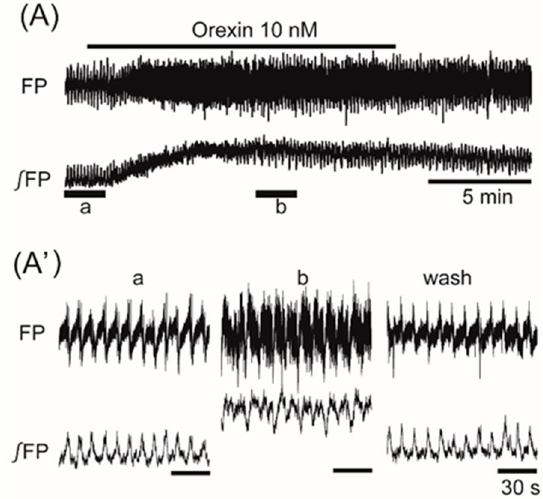
Figure 5. The effects of orexigenic neuropeptide orexin on oscillation in the ventromedial hypothalamus. ( A ) An example of continuous recording of the ventromedial hypothalamus field potential before and after the application of 10 nM orexin. ( A’ ) Faster sweep representation: a and b correspond to records at “a” and “b” in ( A ), and after 20-min washout (wash). The frequency of the oscillation was increased by the application of orexin. Note that its application increased background tonic